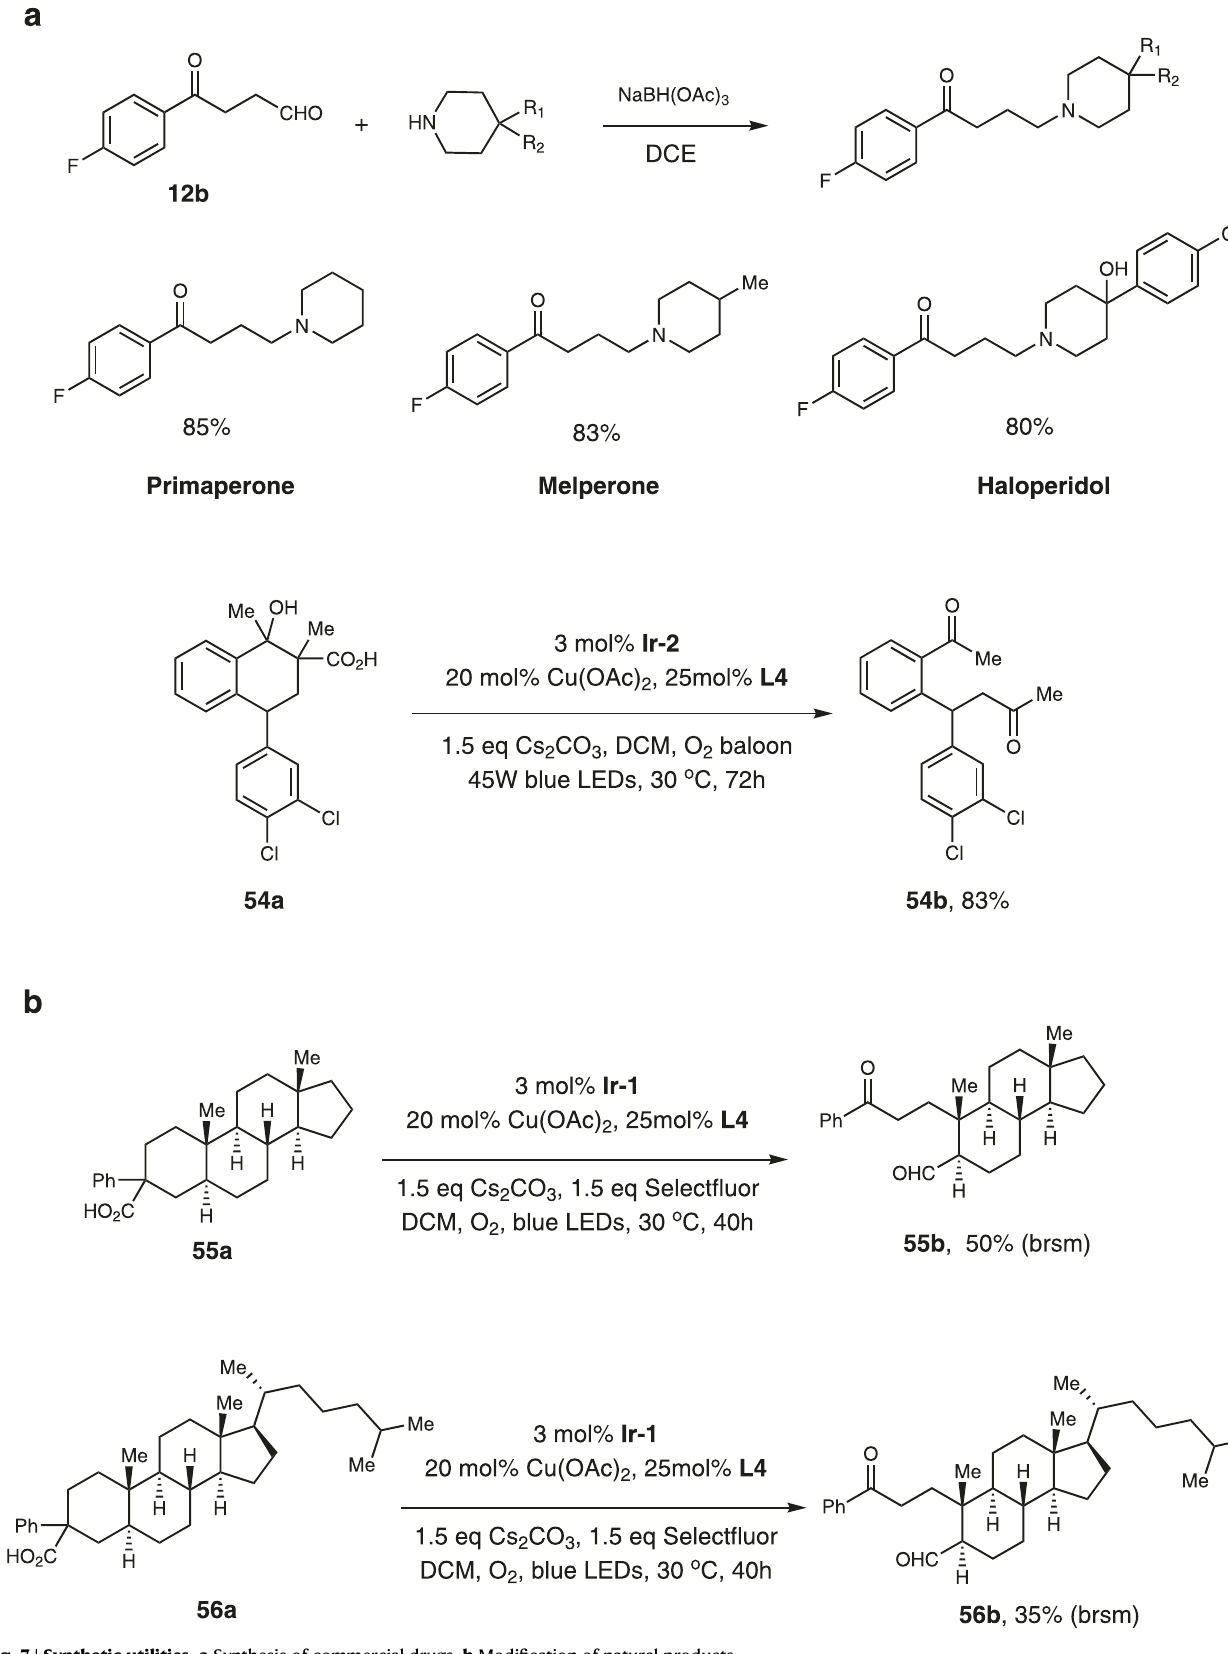
Fig. 7 | Synthetic utilities. a Synthesis of commercial drugs. b Modi fi cation of natural